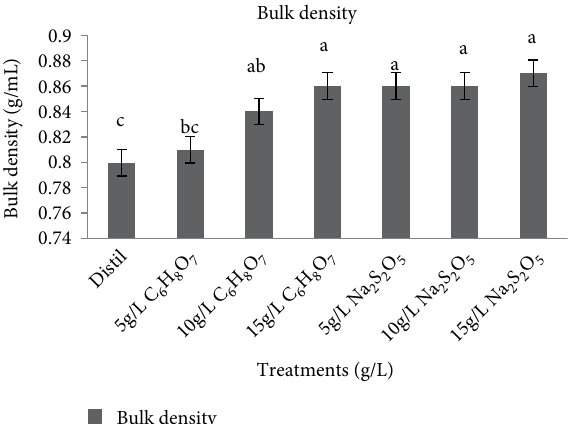
H O = citric acid 6 8 7